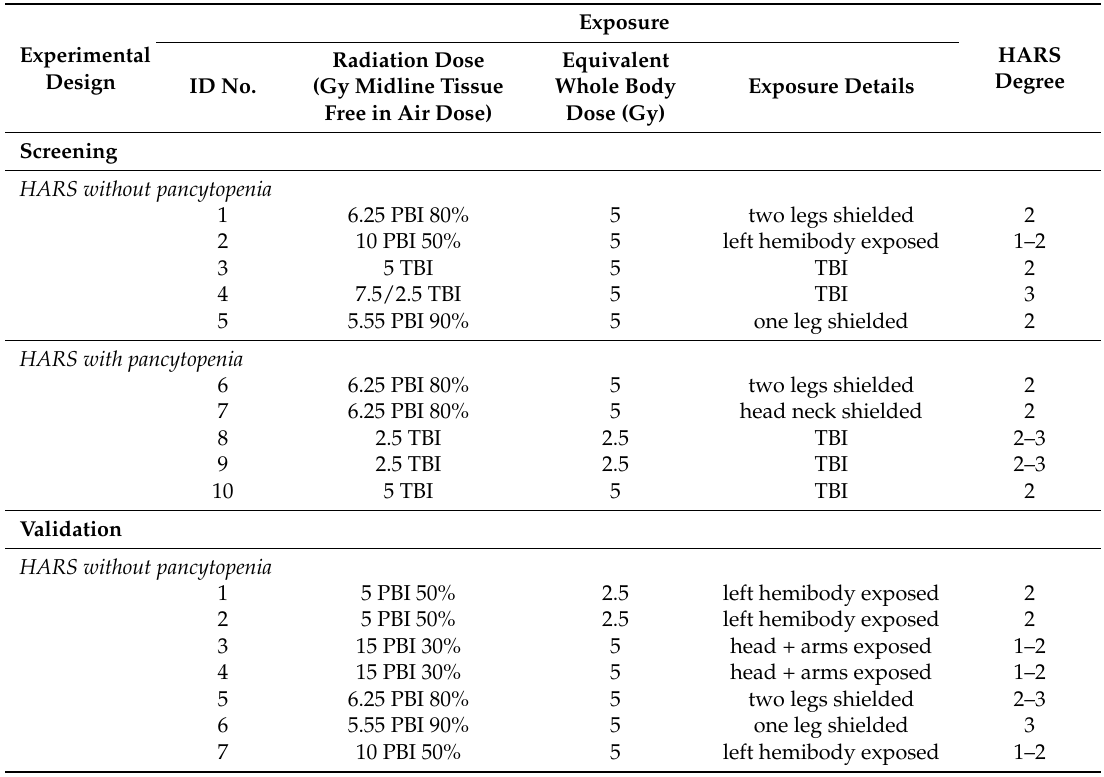
Table 1. Radiation exposure scenarios and resulting haematologic acute radiation syndrome severities.